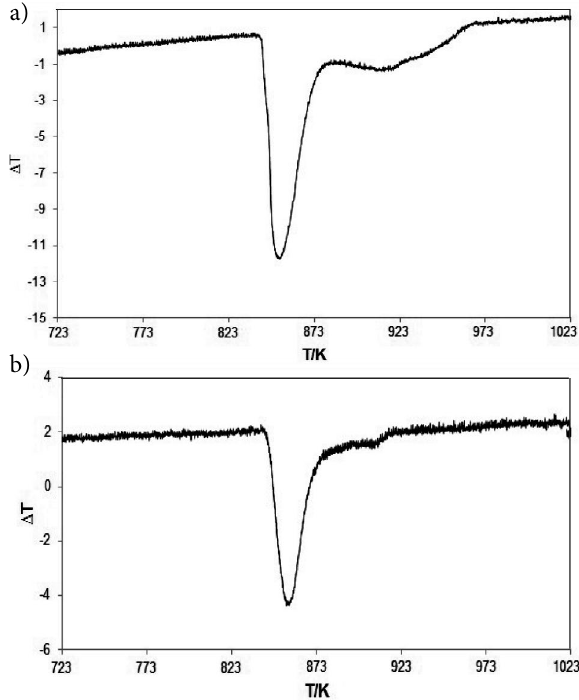
Figure 12. The DTA results in ∆T–T coordinates for (SnAs) 0.5 (GeAs 2 ) 0.5 (a) and (Sn 0.39 As 0.61 ) 0.7 (Ge 0.28 As 0.72 ) 0.3 (b)